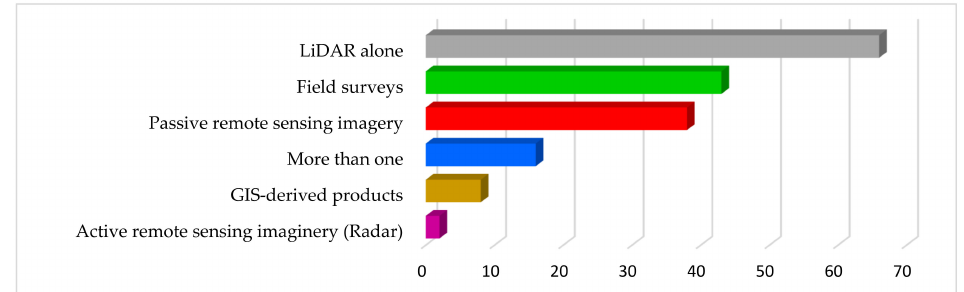
Figure 4. Number of articles found in the literature search using LiDAR data together with other sources: “GIS-derived products” refer to thematic maps or variables extracted from GIS analyses not linked to LiDAR data. “More than one” consider articles using at least 2 sources apart from LiDAR data, e.g., field surveys and passive remote sensing